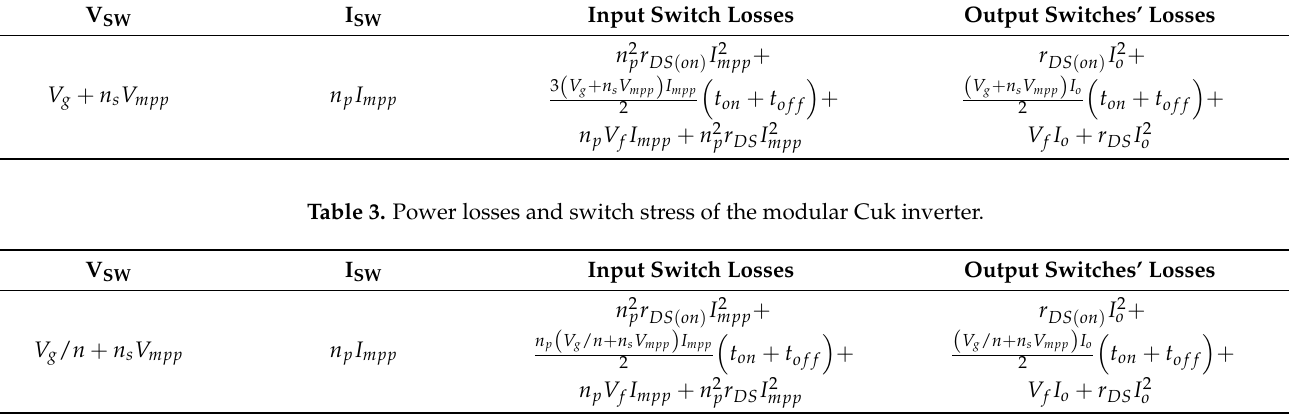
Table 3. Power losses and switch stress of the modular Cuk inverter.